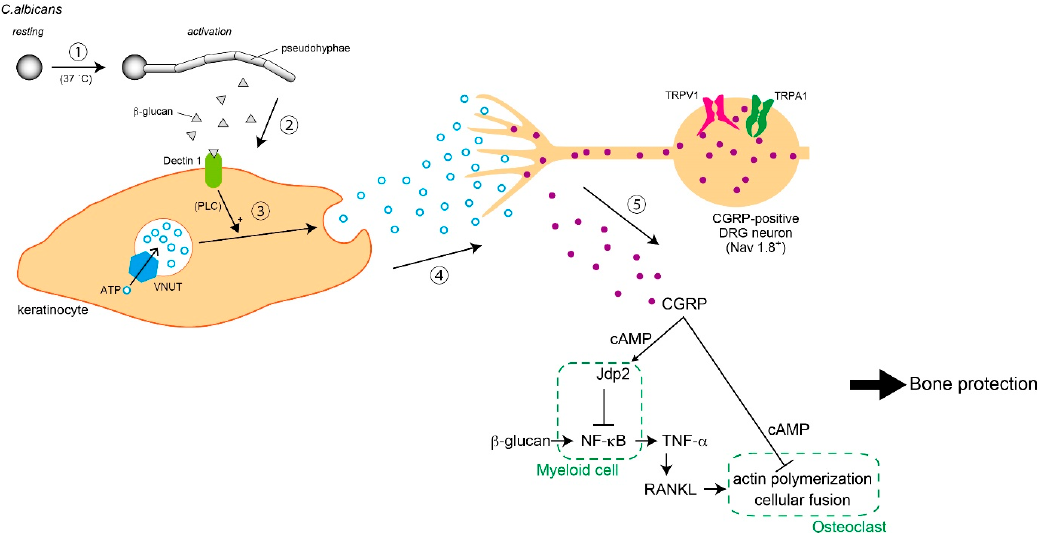
Figure 3. Bone protection system from Candida infection. Bone disruption followed by inflammation is worsened by overactive osteoclasts. Nociceptors suppress osteoclast development through calcitonin gene-related peptide (CGRP) release. The process involves: (1) Candida albicans is activated in an optimal environment (e.g., body temperature); (2) β -glucan released from pseudohyphae bind to its receptor, dectin-1, on the plasma membrane of keratinocytes; (3) ATP release from keratinocytes is enhanced through the phospholipase C (PLC) pathway; (4) neuronal excitation in voltage-gated sodium channel 1.8 (Nav1.8)-positive dorsal root ganglion (DRG) neurons; and (5) CGRP release from DRG neurons. Jun dimerization protein 2 (Jdp2) is activated by CGRP through a cAMP cascade in myeloid cells. In turn, tumor necrosis factor-alpha (TNF- α release (which accelerates osteoclast development) is suppressed. TNF- α -dependent inflammation is induced by the direct e ff ect of β -glucan on myeloid cells. Furthermore, the CGRP–cAMP axis in osteoclasts also inhibits over-development. Thus, these pathways from skin to bone induce bone protection and inhibit bone inflammation during fungus infection.